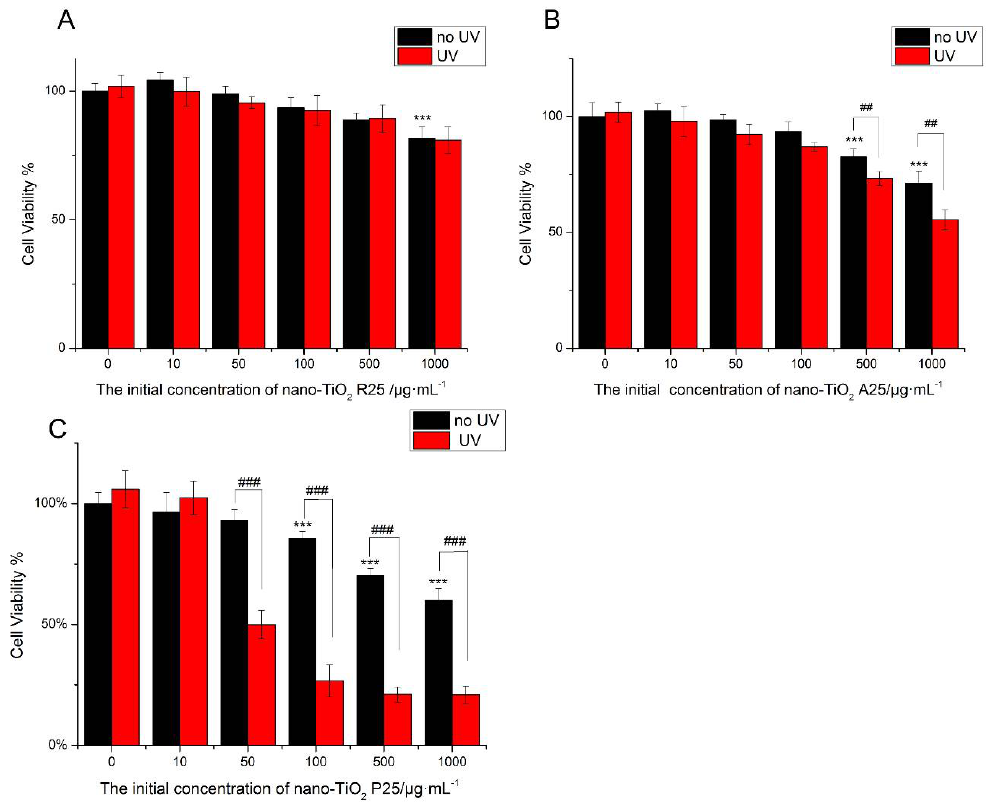
Figure 2. The effects of 24 h of exposure of human skin keratinocytes (HaCaT) cells to nano-TiO 2 ( A ) R25, ( B ) A25, and ( C ) P25 with or without ultraviolet (UV) irradiation. Cell viability was quantified by 3-(4,5-Dimethylthiazol-2-yl)-2,5-diphenyltetrazolium bromide (MTT) assay. Significant